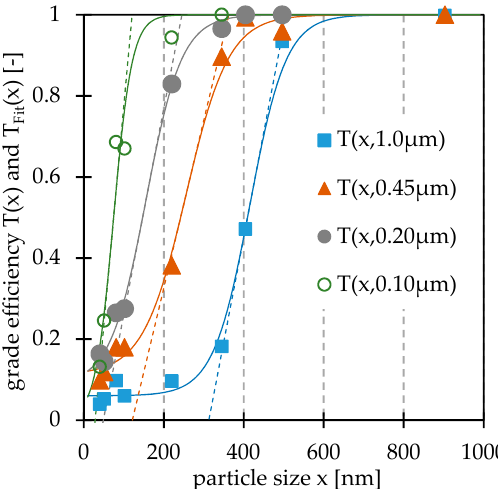
Figure 2. Results of polystyrene suspension filtration studies: Grade efficiencies T(x) (data and fitted curves) and related inflection tangents of OMNIPORE ® membranes.